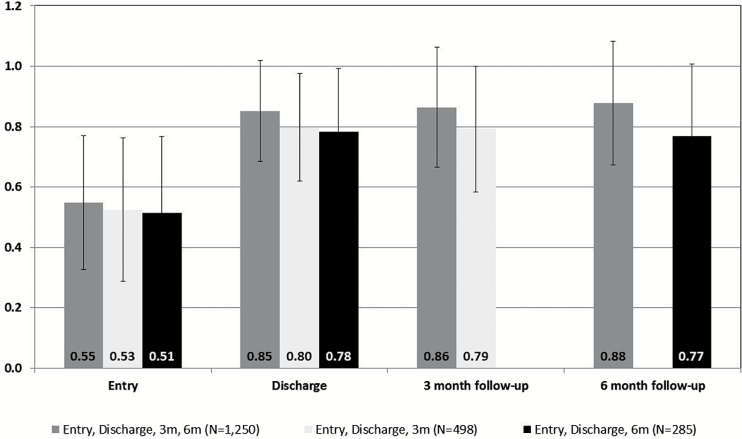
EQ-5D index score for entry, discharge, 3 and 6 months post-discharge.